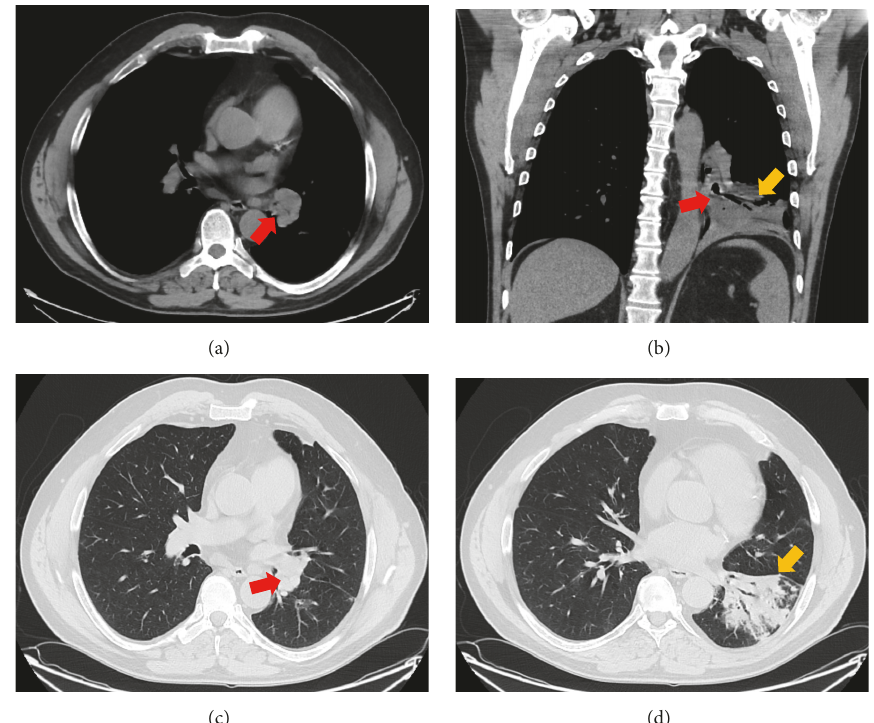
Figure 1: Computed tomogram (CT) of the chest (mediastinal window) in horizontal view (a) and coronal view (b) showing a narrow left lower lobe (LLL) bronchus (red arrow) and distal postobstructive consolidation (yellow arrow). CT of the chest (lung widow) in horizontal view ((c) and (d)) also depicting the narrowed LLL bronchus (red arrow) with the distal consolidation (yellow